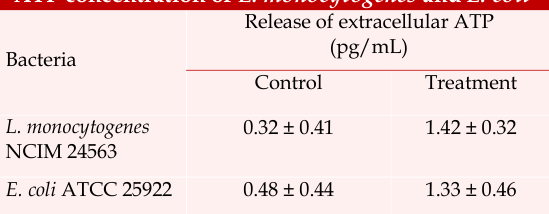
Effect of the C. bonducella seed oil on extracellular ATP concentration of L. monocytogenes and E. coli